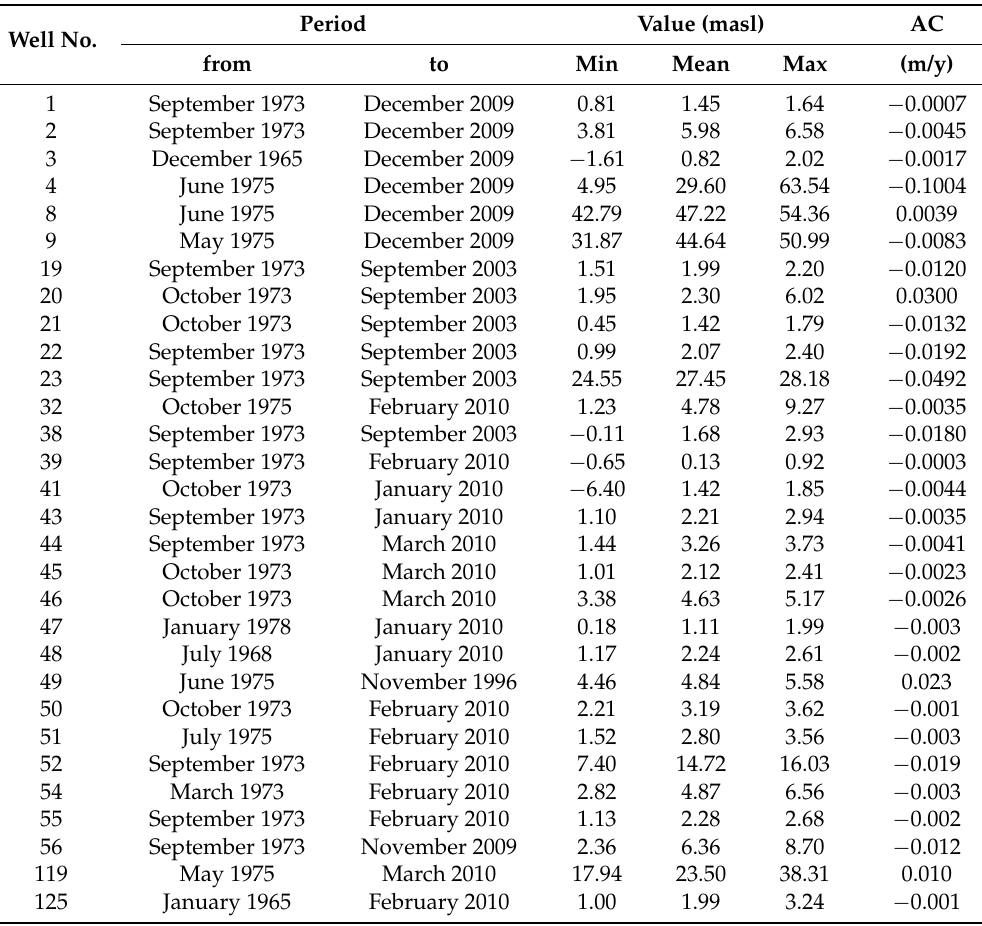
Table 1. Statistical values of the selected piezometric time series (AC: angular coefficient of straight line trend).